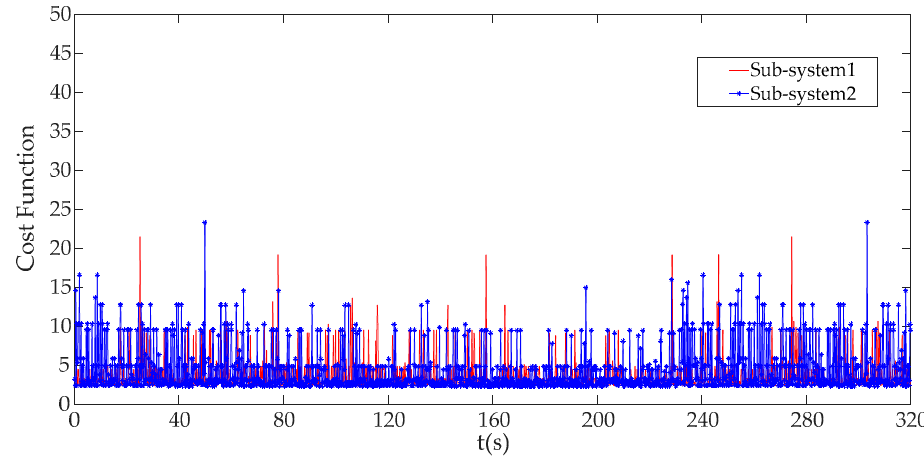
Figure 17. The cost function without DoS attack.